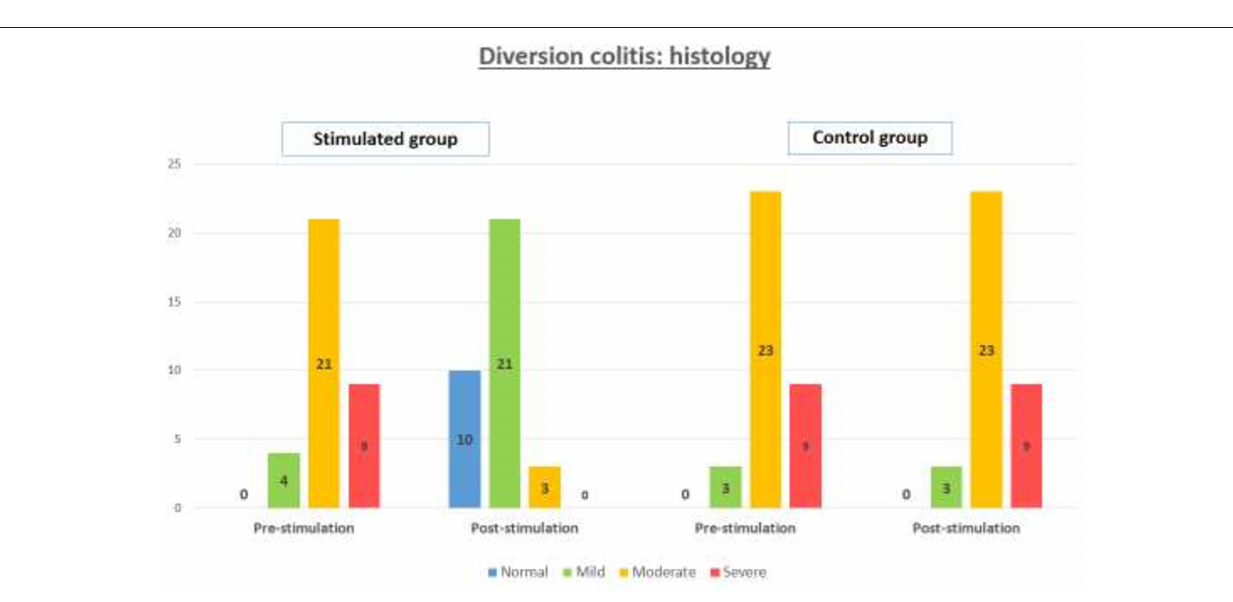
present in CG with 28.6% ( n = 10) compared to 71.4% who are asymptomatic ( n = 25). SG shows 100% asymptomatic